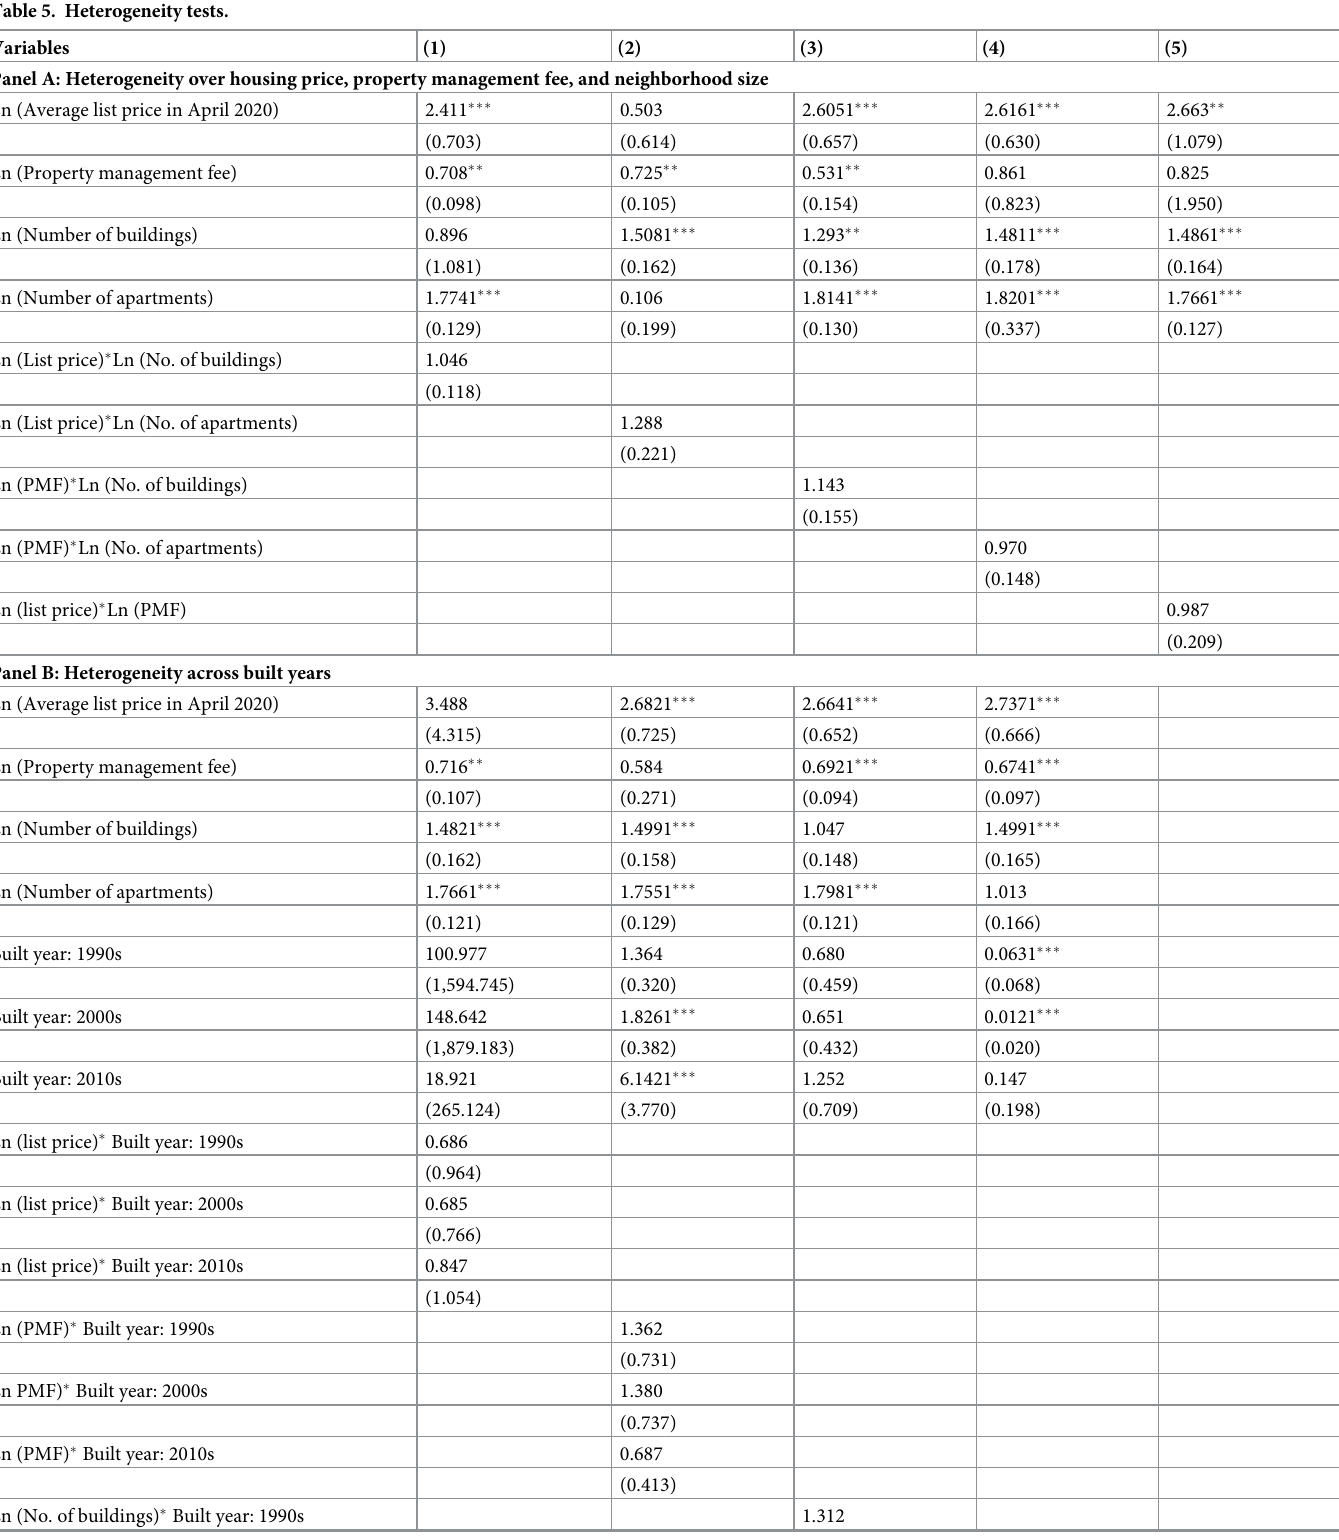
Table 5. Heterogeneity